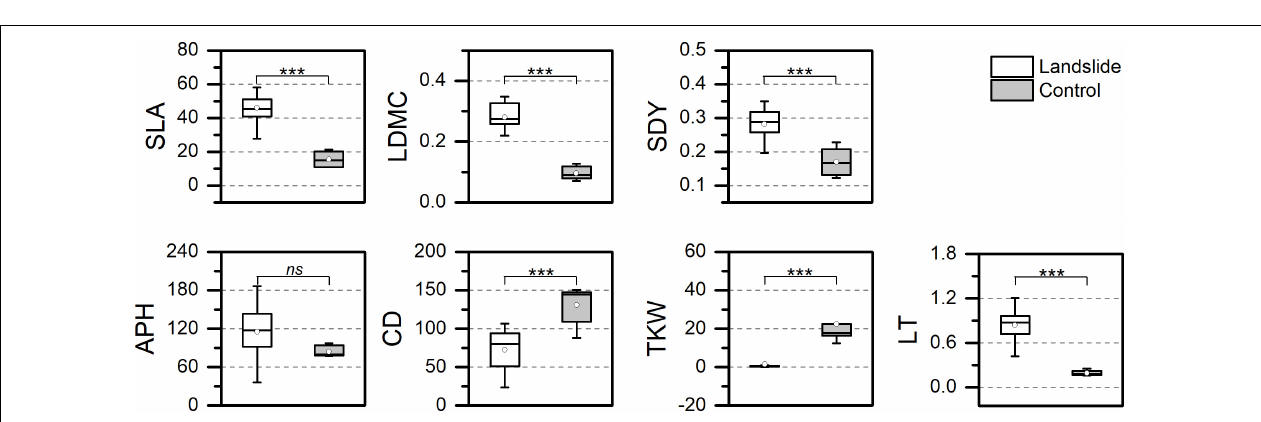
FIGURE 2 | The difference in community functional traits of herbaceous plants between landslide and non-landslide sites. SLA, specific leaf area; LDMC, leaf dry matter content; SRL, specific root length; LT, leaf thickness; APH, average plant height; CD, crown diameter; TKW, thousand kernel weight; ns, non-significant; ***, significant at the 0.01 level.